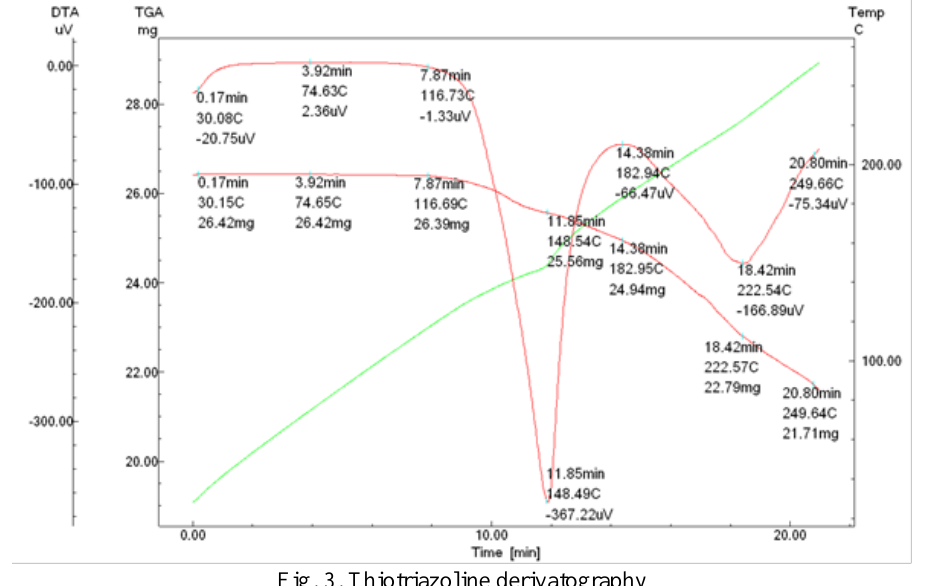
Fig. 3. Thiotriazoline derivatography